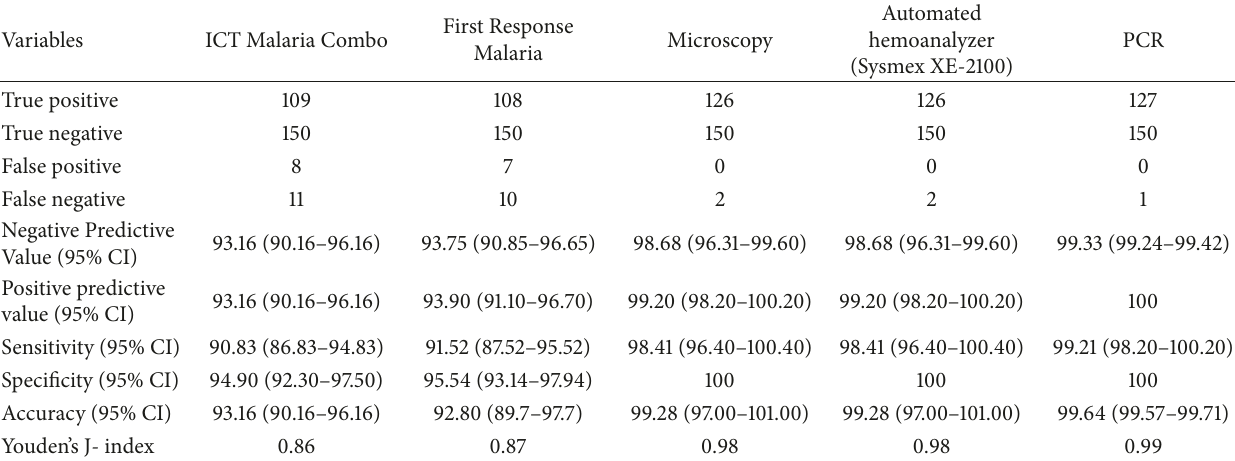
Table 2: Performance analysis of different tests with species-specific PCR as internal control.